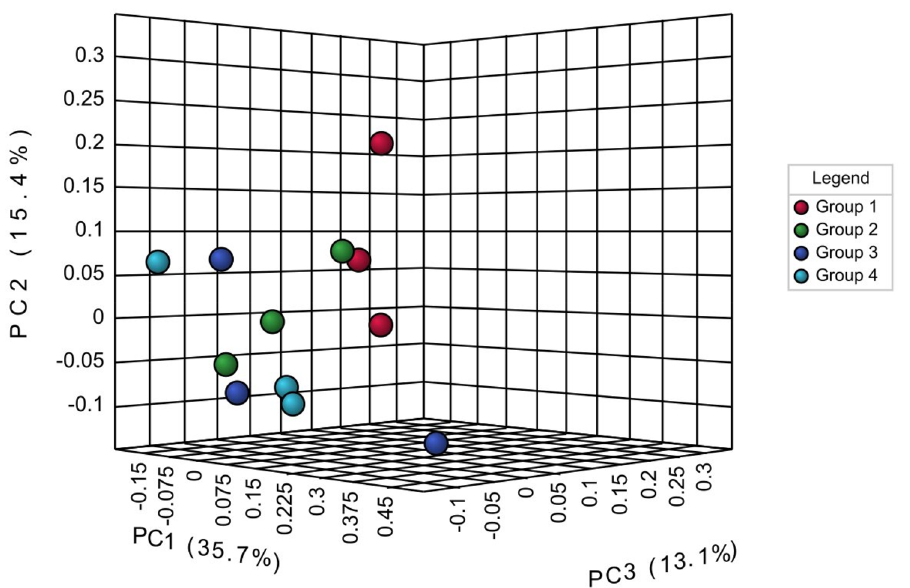
Figure 2. The results of 3D PCA visualization against all disease severity indices to see differences in metabolite profiles in each severity